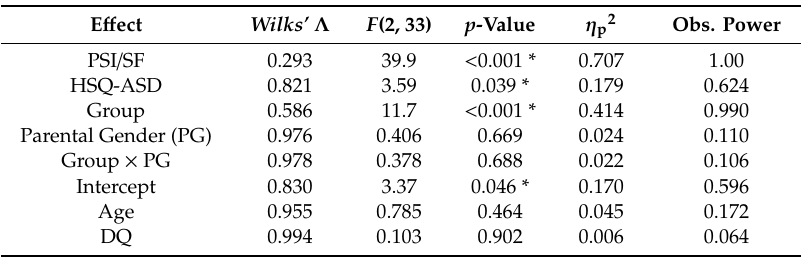
Table 2. Multivariate tests for primary outcome variables.